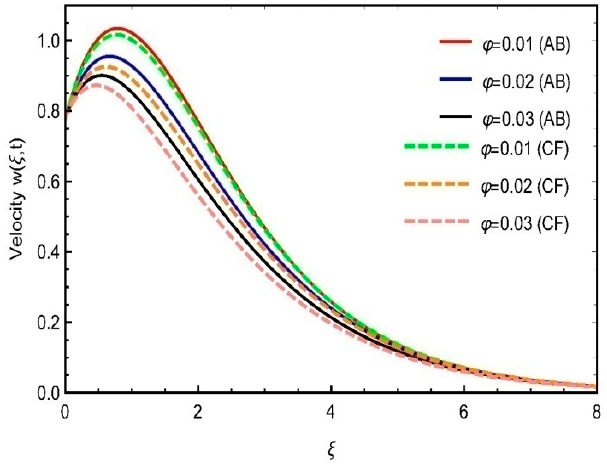
Figure 5. Change in velocity for ϕ .